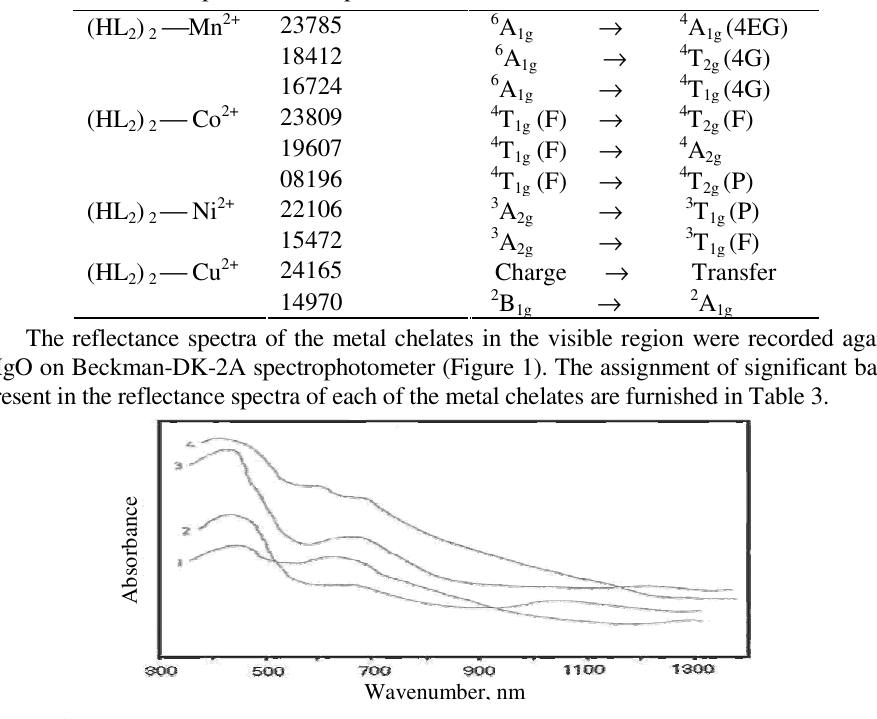
metal complexes (1) HL 2